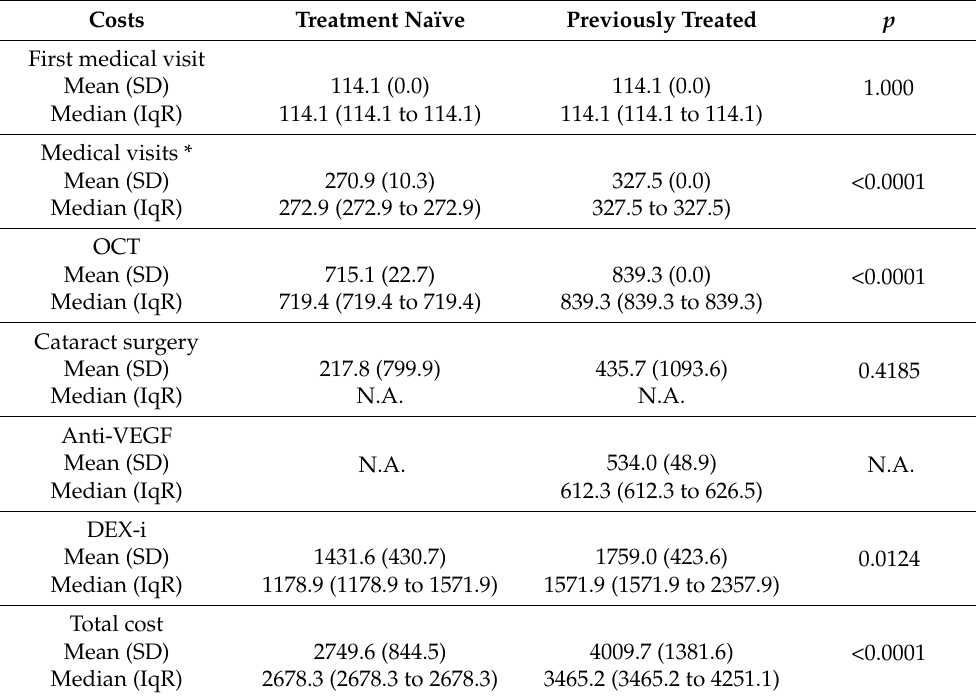
Table 2. Comparison of the different costs considered in the study between treatment-naïve and previously treated groups. p value was calculated using the Mann–Whitney